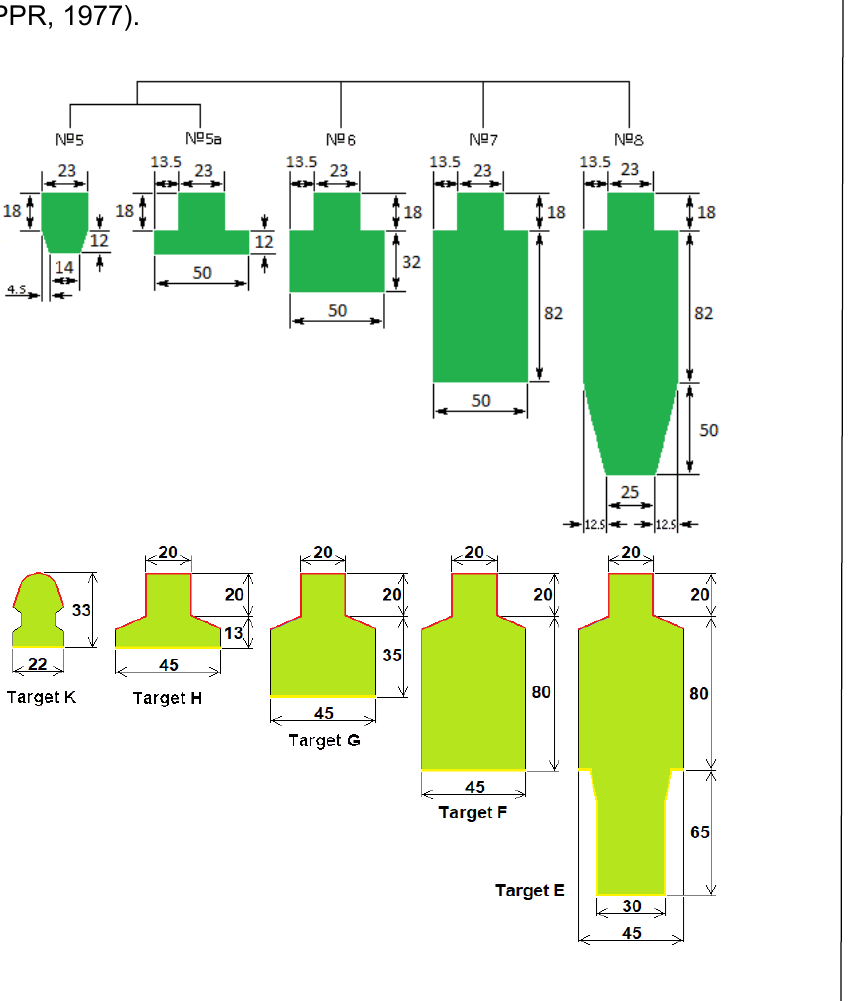
Figure 1 – Silhouettes of five Soviet/Russian PSTs (top row) and five Swiss shooting targets (cibles de campagne) (bottom